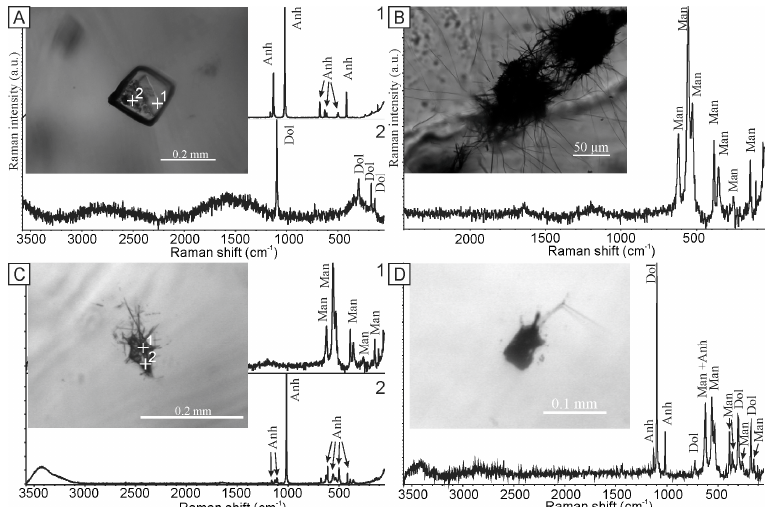
Figure 6. Microscopic images of fluid inclusion and Raman spectra of: ( A ) euhedral anhydrite (Anh) crystal (point 1) and fine crystalline dolomite (Dol, point 2) in liquid inclusion (depth − 1190.5 m a.s.l.). ( B ) Densely packed needles of manganite (Man) in fluid inclusion (depth − 1187.6 m a.s.l.). ( C ) Needles of manganite (Man) with anhydrite (Anh) (depth − 1187.6. m a.s.l.). ( D ) Inclusion filled by fine crystalline, opaque dolomite (Dol) with manganite (Man) (depth − 1187.6 m a.s.l.).